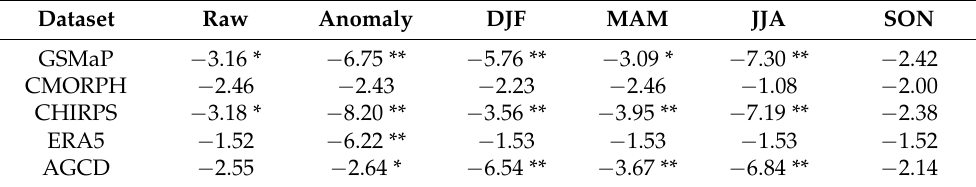
Table 1. Augmented Dickey–Fuller Test results for each season, as well as the score for significance. Dataset